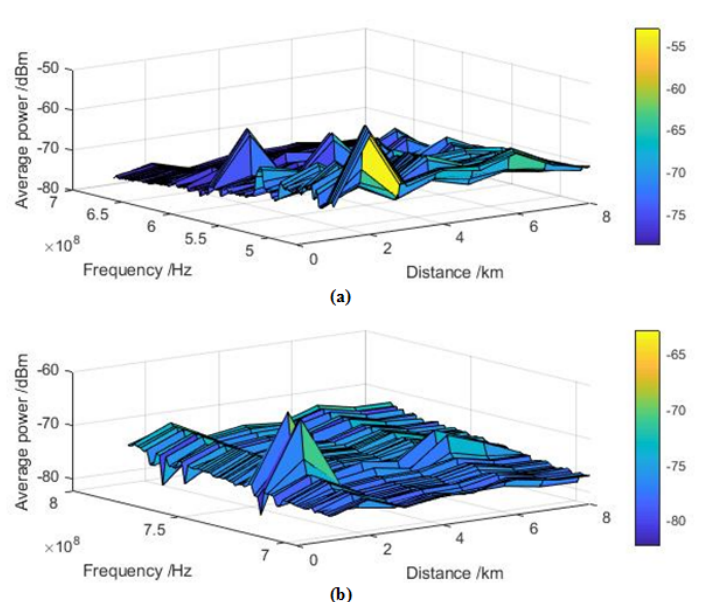
Figure 3. Radiofrequency intensity at different measurement locations for the different distances: The frequency ranges are 470 MHz-694 MHz for (a) and 694 MHz -790 MHz for (b) Theoretically, radiofrequency intensities at a constant distance from the broadcasting transmitter must